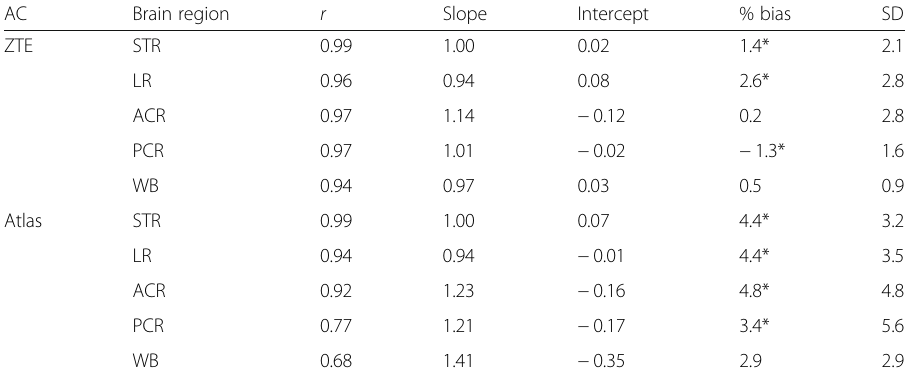
Table 2 Correlation coefficient r , slope and intercept of orthogonal regression across subjects for SUVR values in different brain clusters when comparing ZTE- and atlas-attenuation correction (AC) with 68 Ge-AC. In addition, mean bias (%) and accuracy (SD of % bias) are given AC Brain region Slope